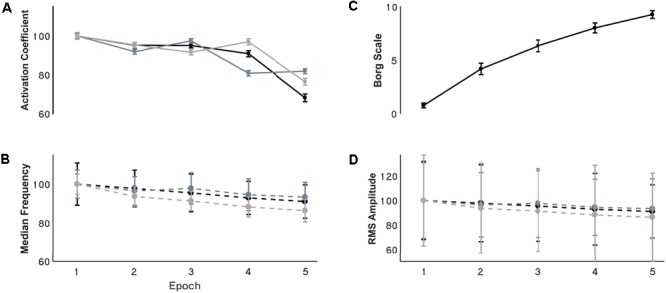
Resultant (A) synergy activation coefficients, (B) median frequency, (C) Borg scale, and (D) RMS amplitude through the development of fatigue. (A,B,D) Are normalized with respect to the first epoch value. Error bars show the 95% confidence interval. For the activation coefficient panel, black, grey, and light grey traces represent internal rotation, flexion and extension synergies respectively. For the EMG parameters the black, grey and light grey traces represents the MT, AD, and ST muscles respectively.